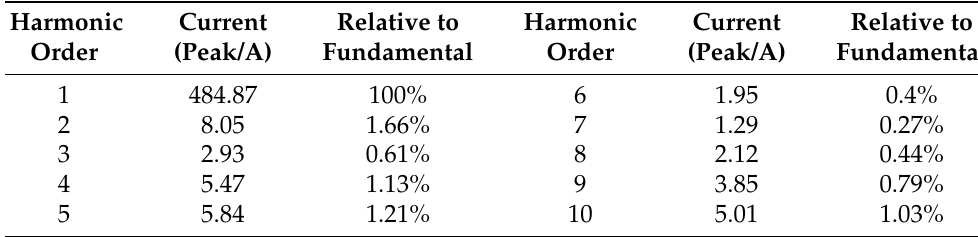
Figure 13. Measured current and voltage curve in rated state. Table 7. The current harmonic